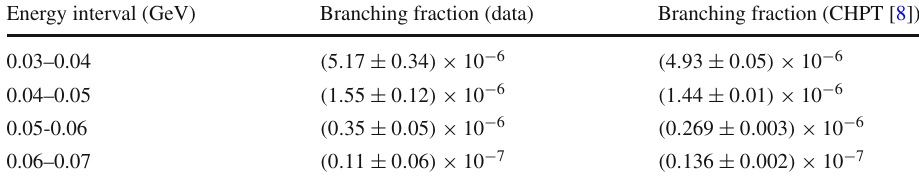
Table 1 Values of the branching fractions for the decay K + → π + π − π + γ in the intervals of the photon energy in the kaon rest frame. The uncertainties of the data given in the table are the statistical